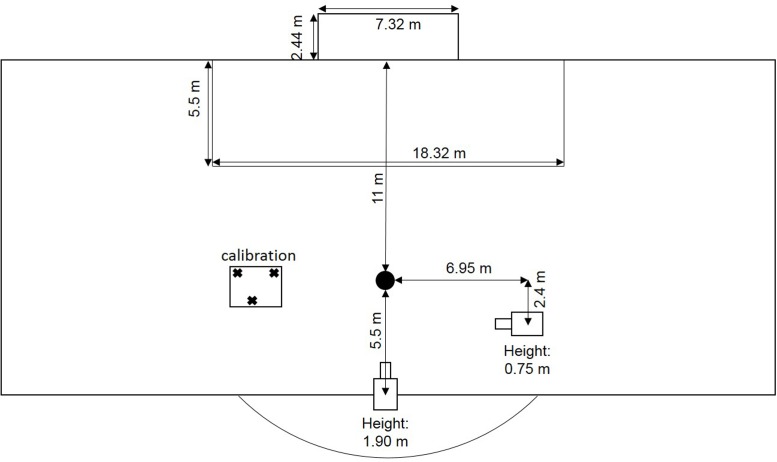
Experimental setup.